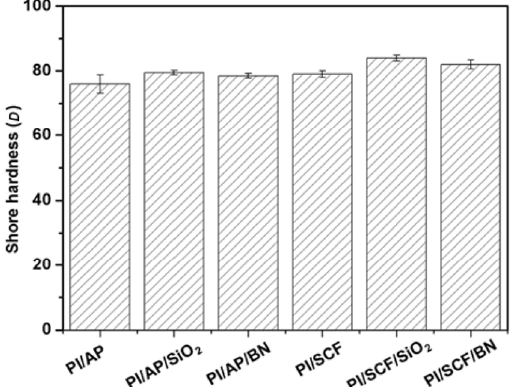
Fig. 3 Shore hardness ( D ) of the PI composites.